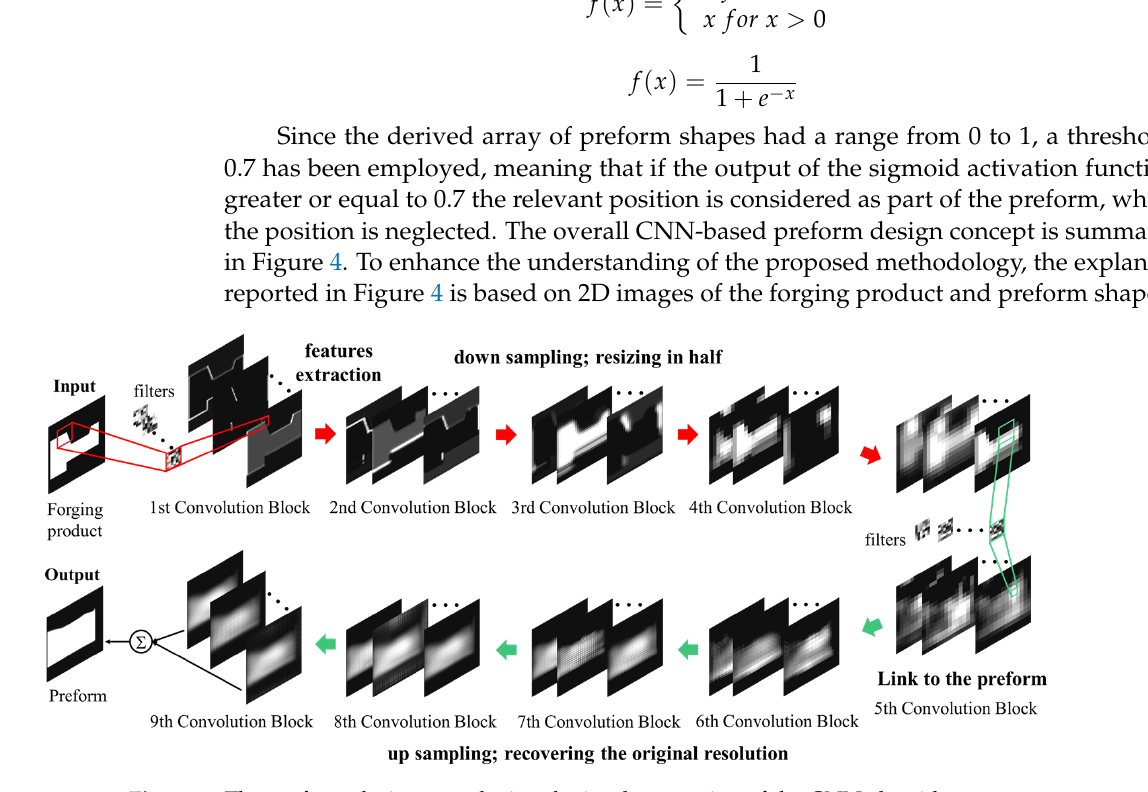
Figure 4. The preform design step during the implementation of the CNN algorithm.